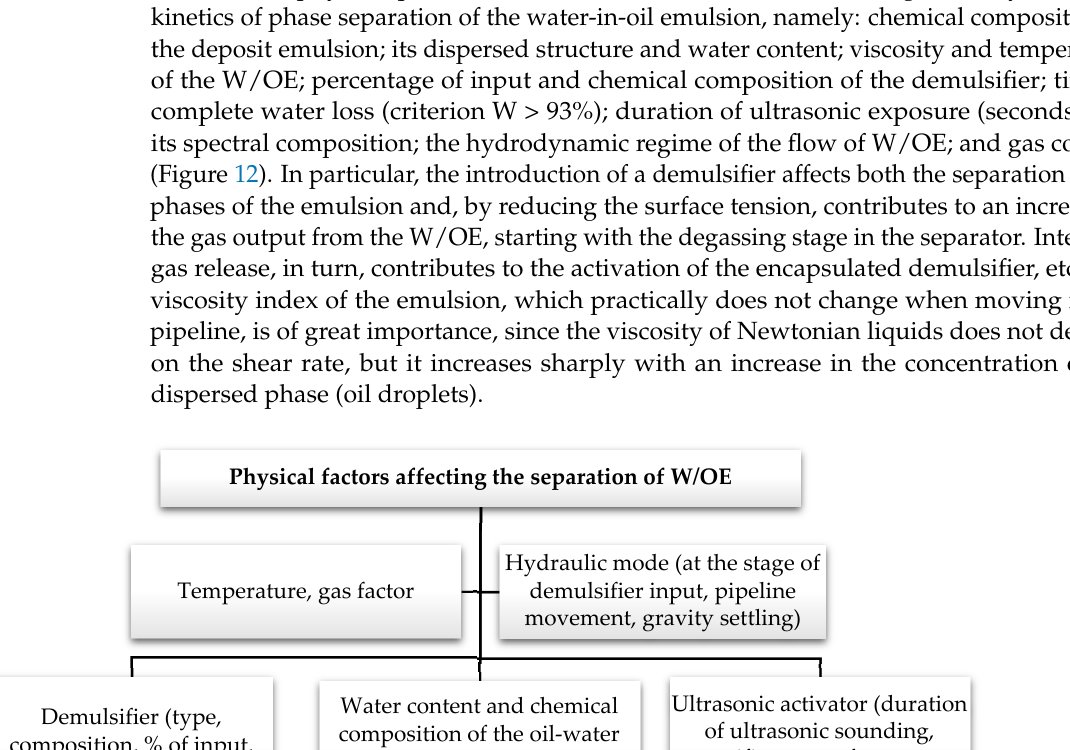
( b ) Figure 13. ( a ) T-shaped mounting scheme of ultrasonic exciters on the pipe; ( b ) The “cross” mounting scheme.